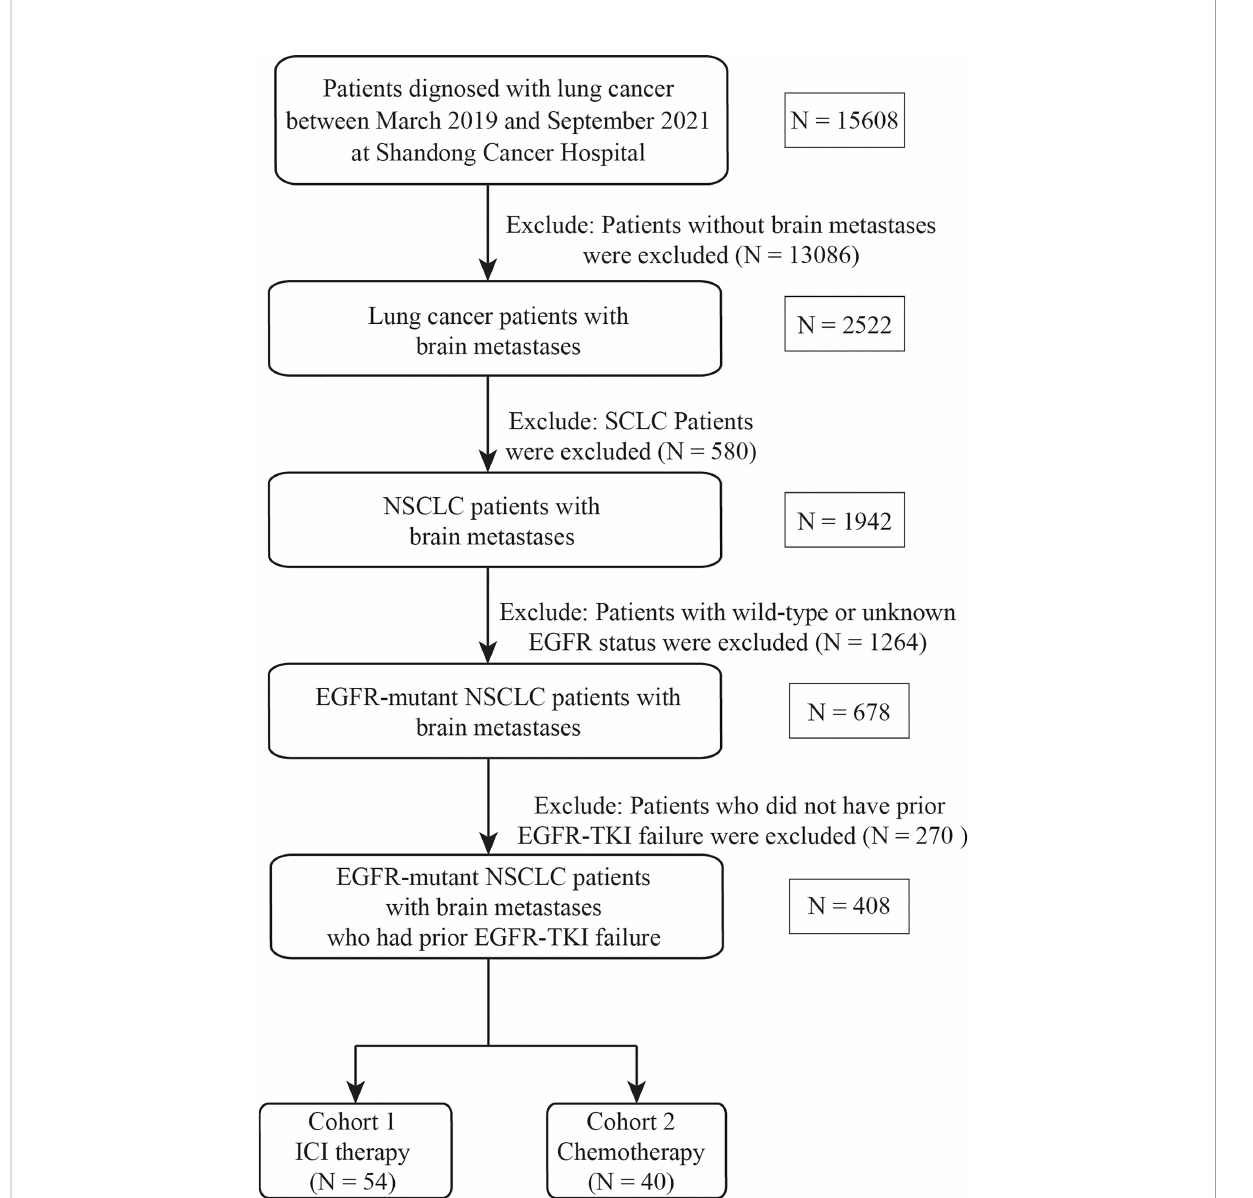
FIGURE 1 Flowchart of the screening procedure. EGFR, epidermal growth factor receptor; SCLC, small cell lung cancer, NSCLC, non-small cell lung cancer, TKI, tyrosine kinase inhibitor; ICI, immune checkpoint